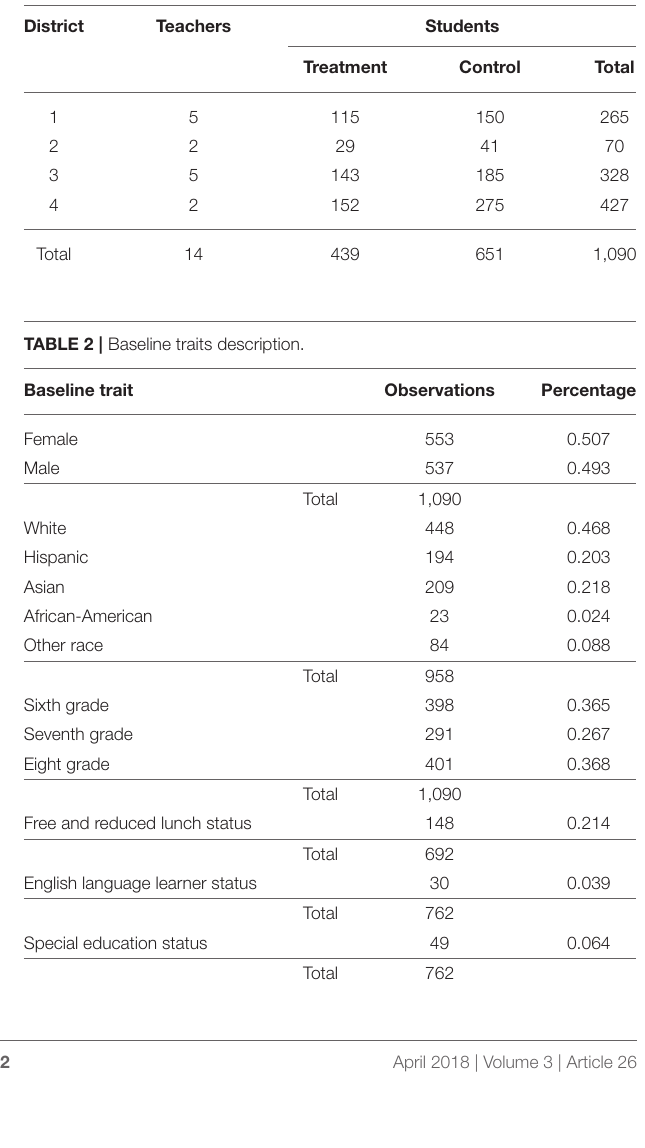
TABLE 1 | Observations used in the study.